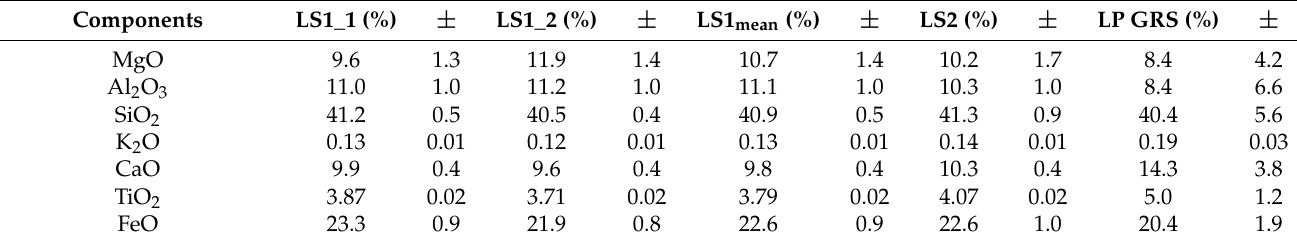
Table 9. Chemical compositions with their 1 σ statistical errors in wt.%, normalized to 99% on account of missing elements, such as Mn, Ni, Cr, P, and Na. Data of orbital chemical compositional measurements are from the gamma-ray spectrometer (GRS) onboard Lunar Prospector (LP) in the